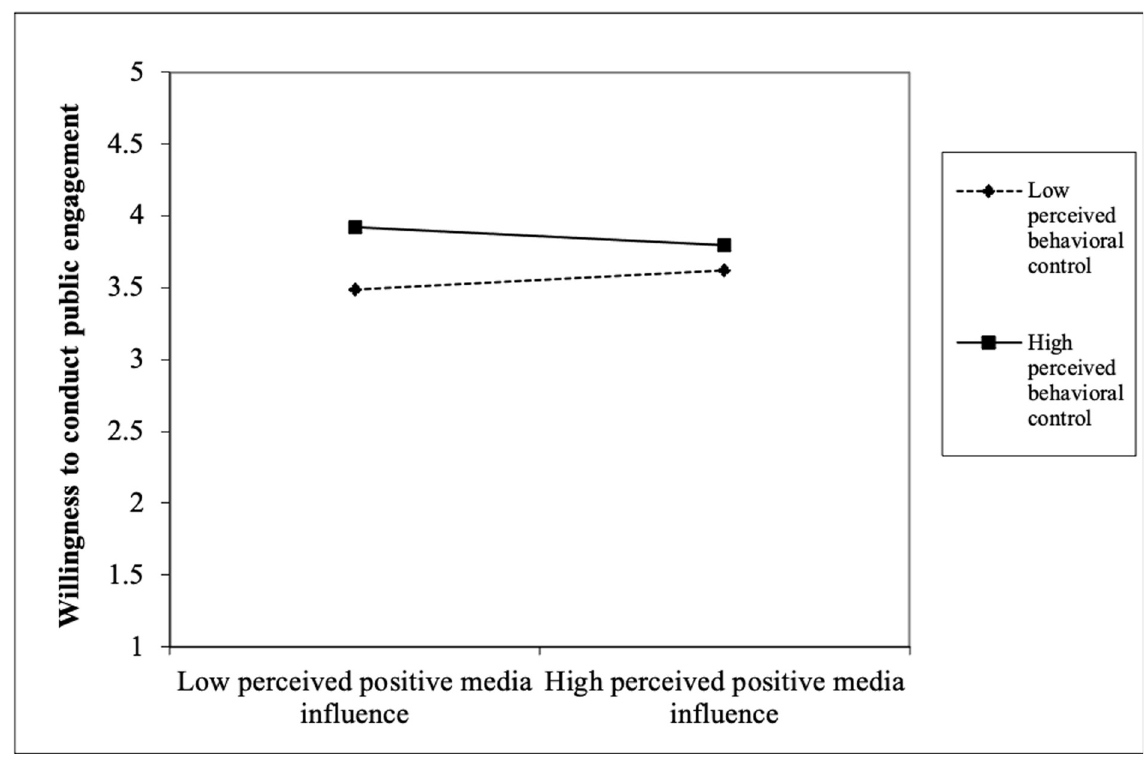
Fig 3. Perceived behavioral control as a moderator of the perceived positive media influence-willingness